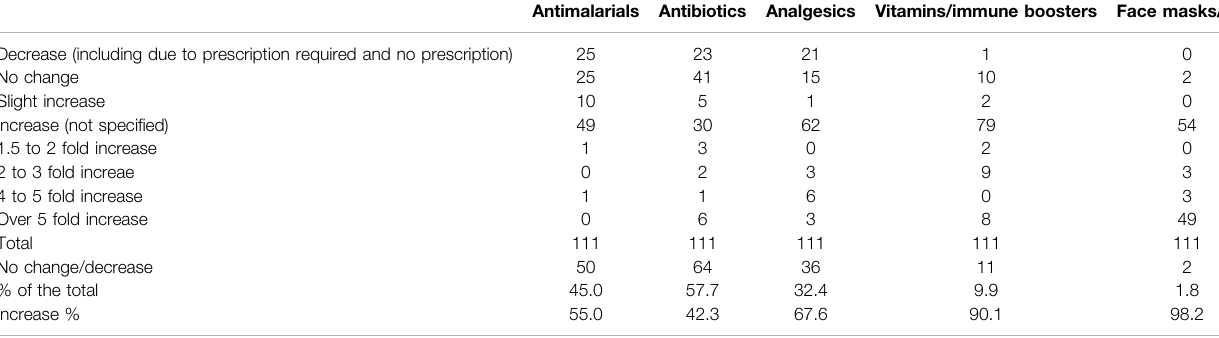
TABLE 4 | Utilisation changes for medicines and PPE between beginning March 2020 and end May 2020 among 111 pharmacies in India. Antimalarials Antibiotics Analgesics Vitamins/immune boosters Face masks/PPE